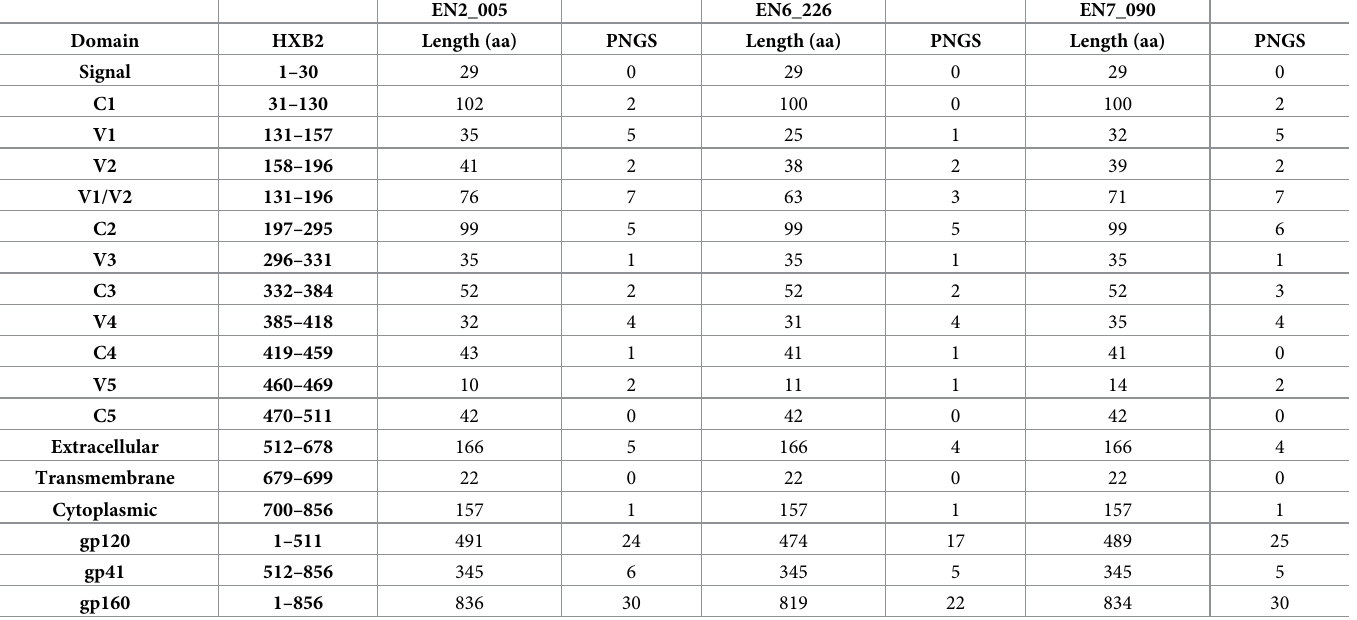
Table 1. Physical characteristic of elite neutralizer/controller rgp120s used in this